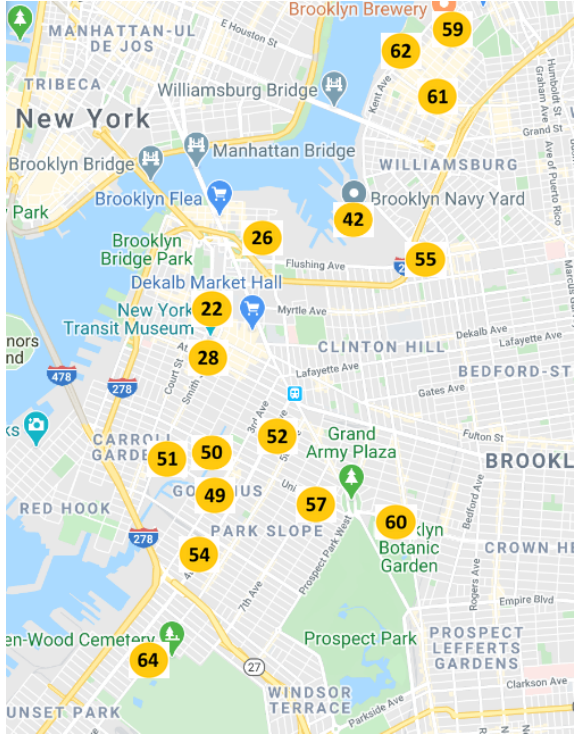
Figure 4. Location of fixed charging stations obtained through computation optimization, Brooklyn, New